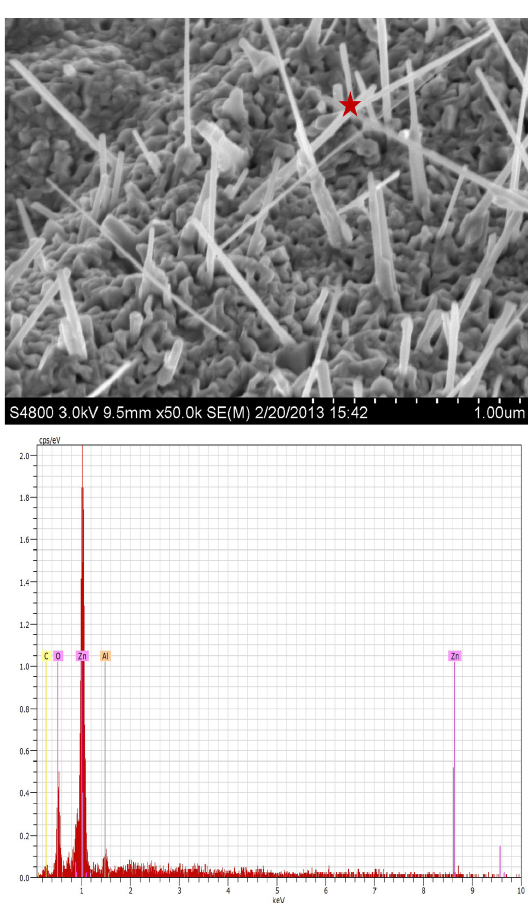
Figure 1. The EDX evaluation of the nanowires observed on the surfaces of the thermally oxidized Cu-32.02% Zn-2.30% Pb